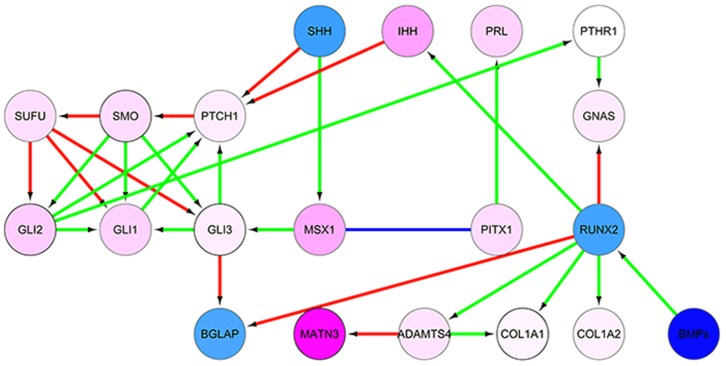
Subnetwork enriched for differential expression by gestational age.Nodes represent genes and are coloured by the fold change of their transcripts by gestational age (blue for positive association with gestational age, pink for negative association). No probe for PTHR1 was included on the array. Arrows represent literature-verified interactions and the colours denote the type of interaction (green for activation, red for inhibition and blue for co-expression).